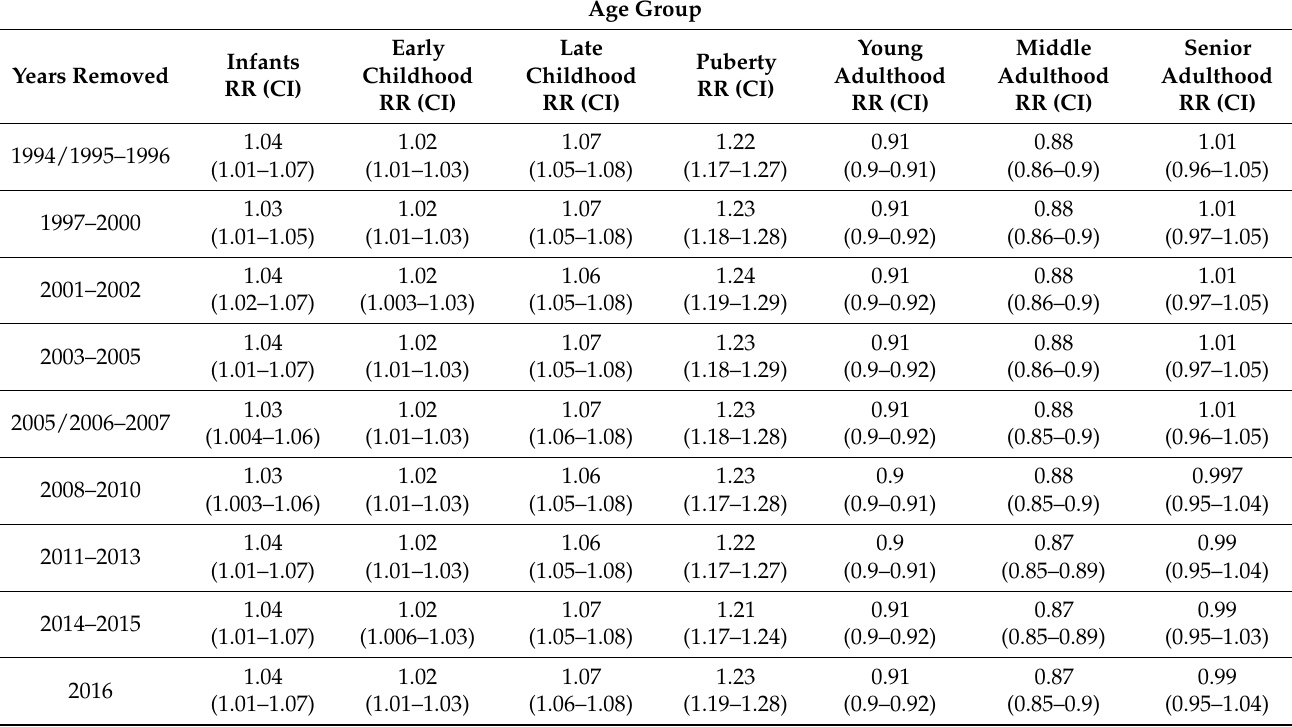
Table 3. Sensitivity analysis, by age group and